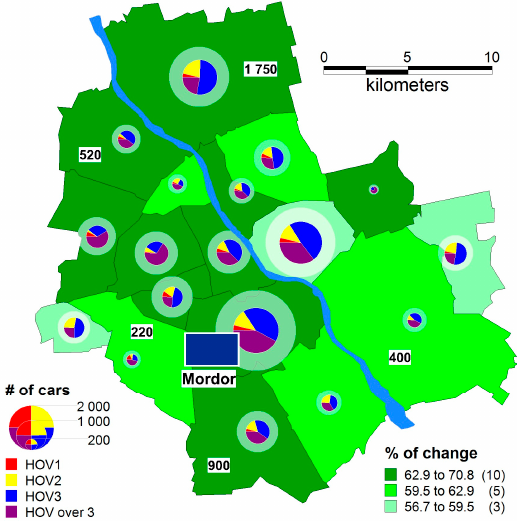
Figure 11. The number of cars (the number of passengers): a pie chart and the percentage change in